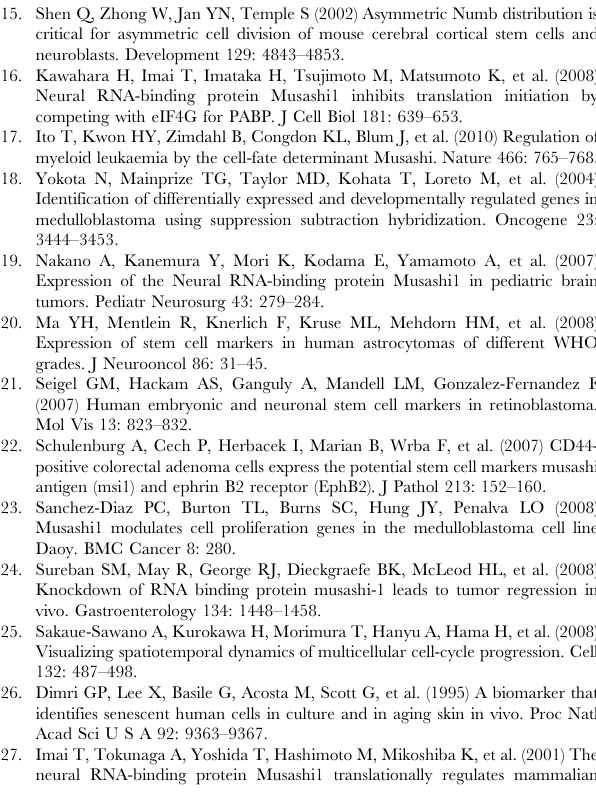
Figure S1 The spheres were dissociated, and the dissociated cells were fixed to coverslips and stained for PH3 in GM1605 cells. (TIF) Figure S2 Colonies were dissociated, and the cells were fixed to coverslips and stained for for cleaved Caspase-3 in GM1605 cells. (TIF) Figure S3 Low passage cells from glioblastoma patients (cell density of 2 6 10 3 cells/well) were assessed for cell proliferation by cell counting. The total cell count in the MSI1 -KD-treated groups on day 15 was reduced by 39% in the GM1605 cells, as compared to the control groups.